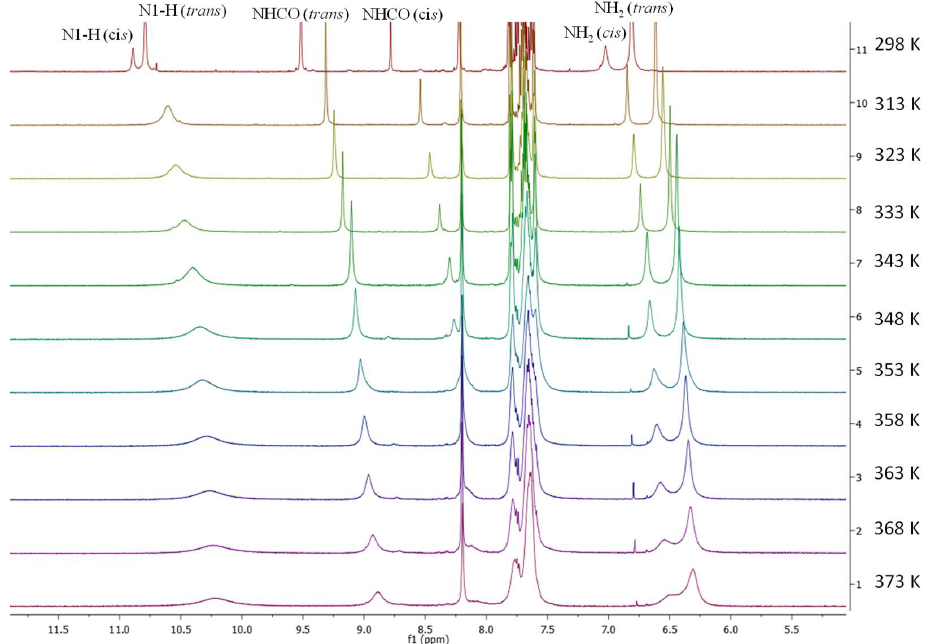
Figure 3. Dynamic NMR experiments of carboxamidouracil 8a at high temperatures. The 1 H-NMR spectra from 5.0 to 12.0 ppm of 8a were measured in DMSO- d 6 at different temperatures, between 298